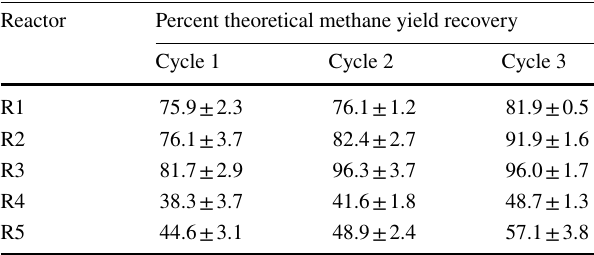
Table 3 Average of the percentage of theoretical methane yield recovery during the successive cycles